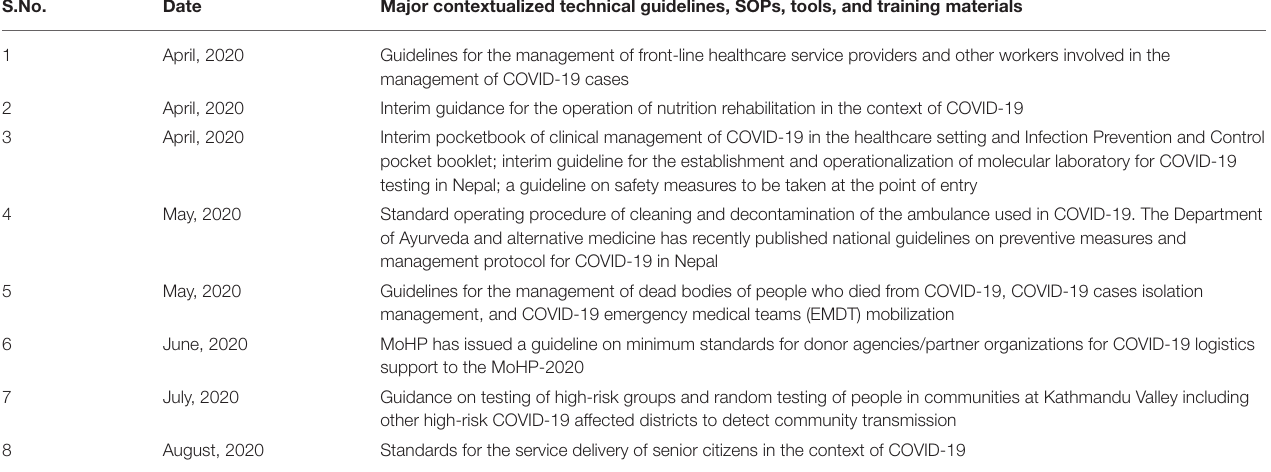
TABLE 3 | Major contextualized technical guidelines, standard operating protocols, tools, and training materials developed by the Government of Nepal (GoN) to respond to COVID-19.